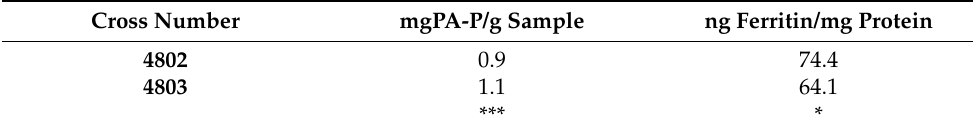
Table 3. T-test comparison of the 4802 and 4803 genetic backgrounds in the 19 lpa breeding lines. Cross